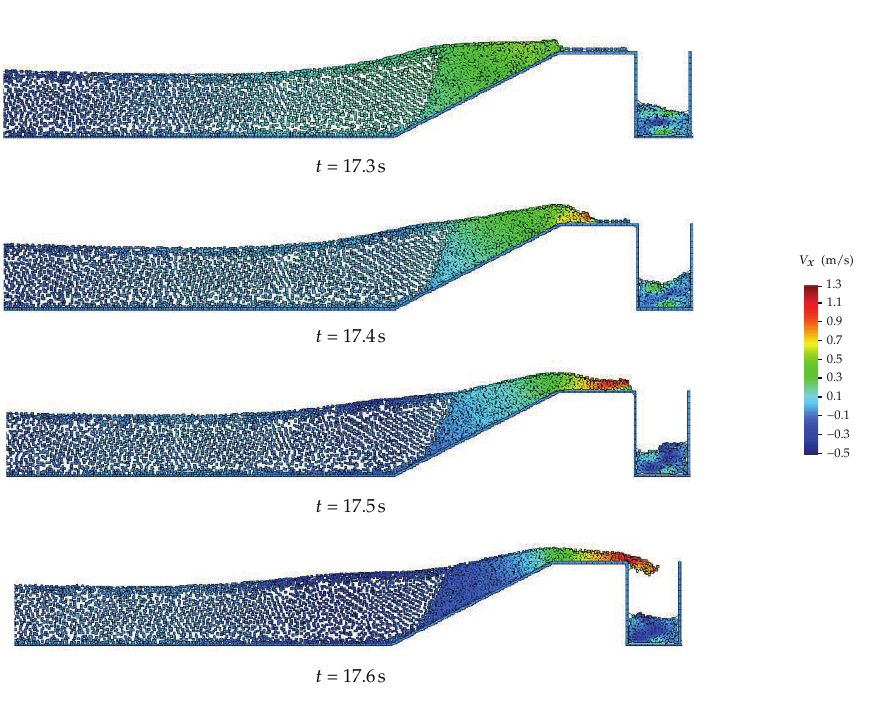
Figure 6: Horizontal velocities (cid:2) m/s (cid:3) close to the low-crested structure for four di ff erent time steps all corresponding to wave case 2 defined by H (cid:9) 0 . 07m and T (cid:9) 1 .